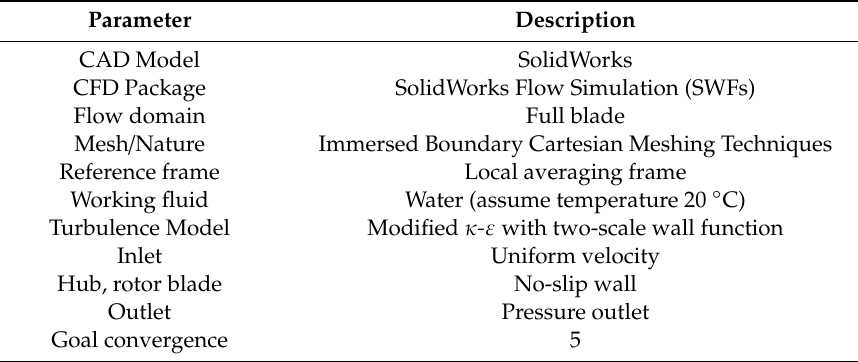
Figure 6. Computational domain with boundary conditions. Table 2. Meshing and boundary